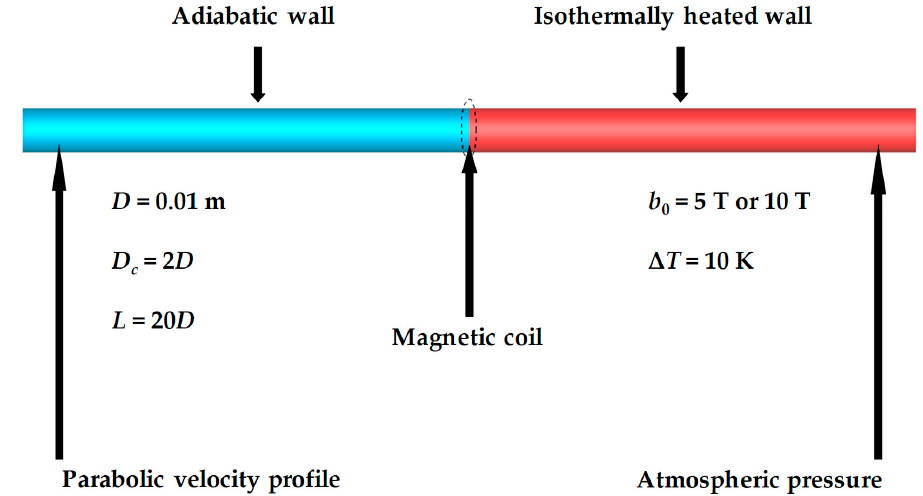
Figure 1. The studied case geometry, important parameters, and boundary conditions.